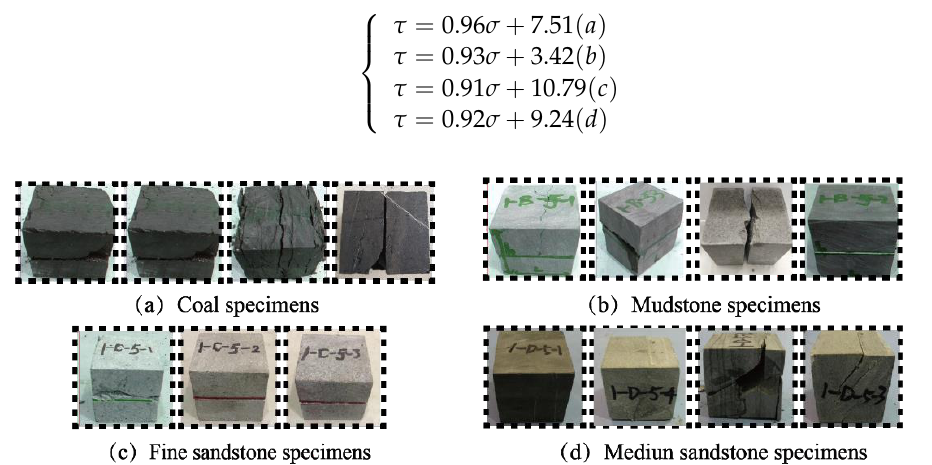
Figure 7. Coal rock variable angle shear specimen.